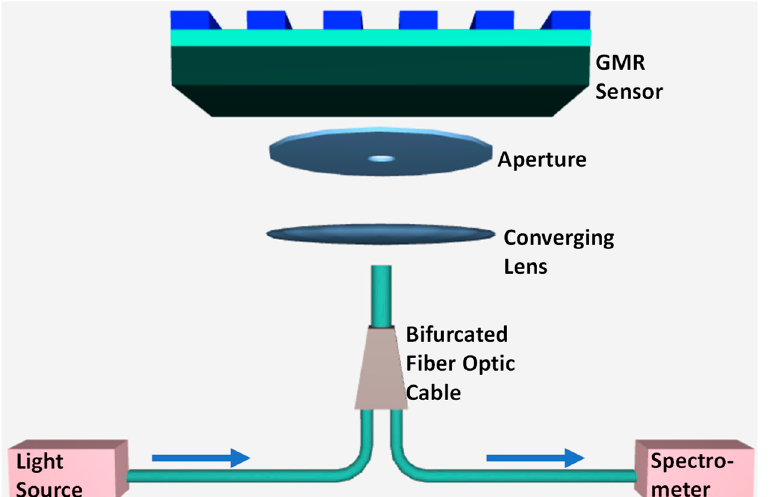
Figure 3. Schematic of the sensor layout. The broadband light from the source is sent through the fiber optic cable, the converging lens, and the aperture. The light then interacts with the GMR sensor and travels back through the optical elements to reach the spectrometer.